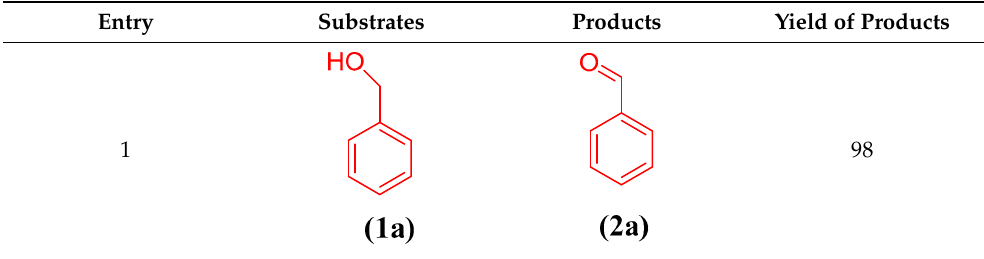
Table 1. Oxidation of different benzyl alcohols catalyzed by gum@Melamine@Cu(II) under optimized conditions.